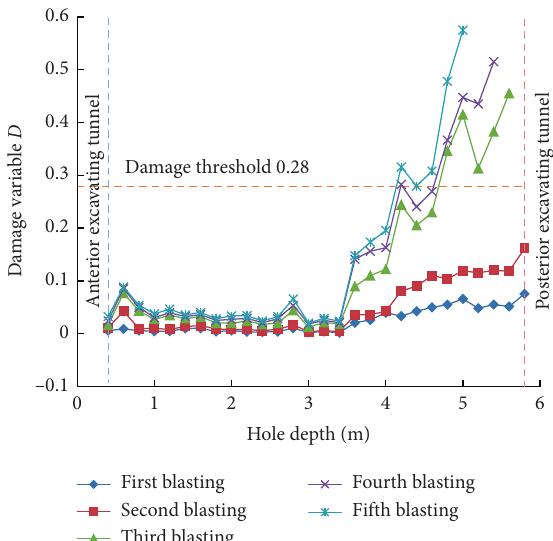
Figure 10: Relation curves between damage variable and hole depth ( L